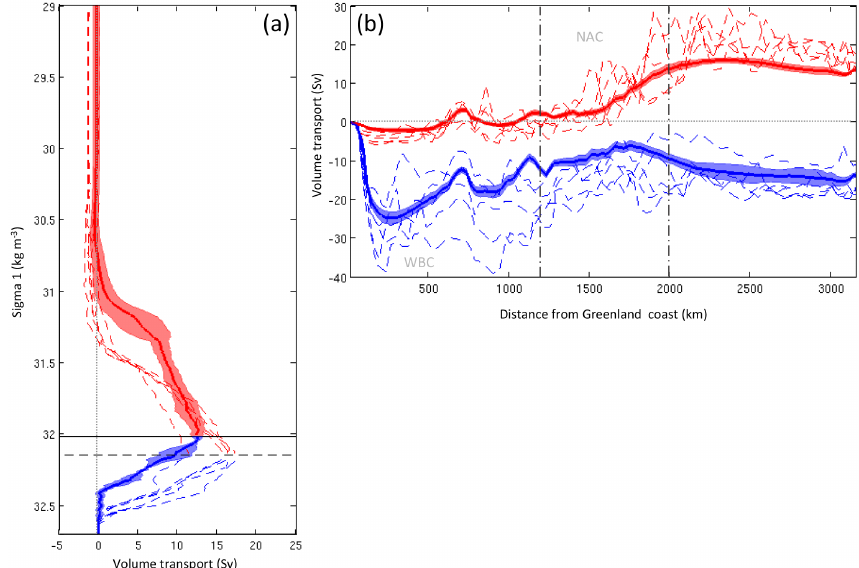
Figure 4. Volume transport (Sv) across the OVIDE section as simulated by the model for the month of June (continuous line for mean value; shaded band for confidence interval) and compared to the observation-based assessments (dashed line) over the period 2002–2010. In panel (a) , the coast-to-coast integrated volume transport was accumulated from the bottom with a 0.01kgm − 3 resolution in density referenced to 1000db ( σ 1 ) . The sign of the profile was changed to get a positive MOC magnitude. Black horizontal lines indicate the density level where the MOC magnitude is found in the model (continuous line; σ MOC = 32.02 ± 0.05kgm − 3 ) and in the observations (dashed line; σ MOC = 32.14kgm − 3 , Zunino et al., 2014). They also represent the separation between the upper (red) and lower (blue) limbs of the MOC. In panel (b) , the volume transport was horizontally accumulated from Greenland to Portugal (km) and vertically integrated over the upper (red) and the lower (blue) limbs of the MOC. Vertical lines represent the limits of the North Atlantic Current (NAC) as reported in Mercier et al., 2015. The position of the western boundary current (WBC) is also indicated. Table 2. Model–data comparison over the period covered by the OVIDE cruises (2002–2010). Average and standard deviation (SD)